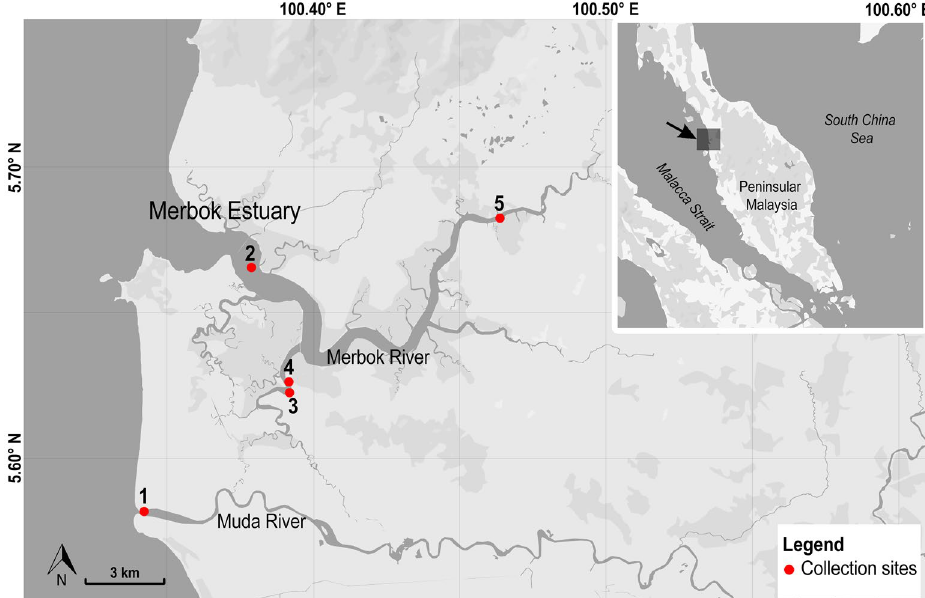
Figure 1. Sampling localities across the study area, which covers the Merbok Estuary (Merbok River) and Muda River. Sampling sites; 1: Kuala Muda Whispering Market, 2: Pompang Sungai Merbok, 3 and 4: Pompang Batu Lintang, 5: Semeling Bridge. Inset map shows the location of the study area within Peninsular Malaysia. Maps are generated using QGIS v.3.4.11 and edited in Adobe Photoshop CC